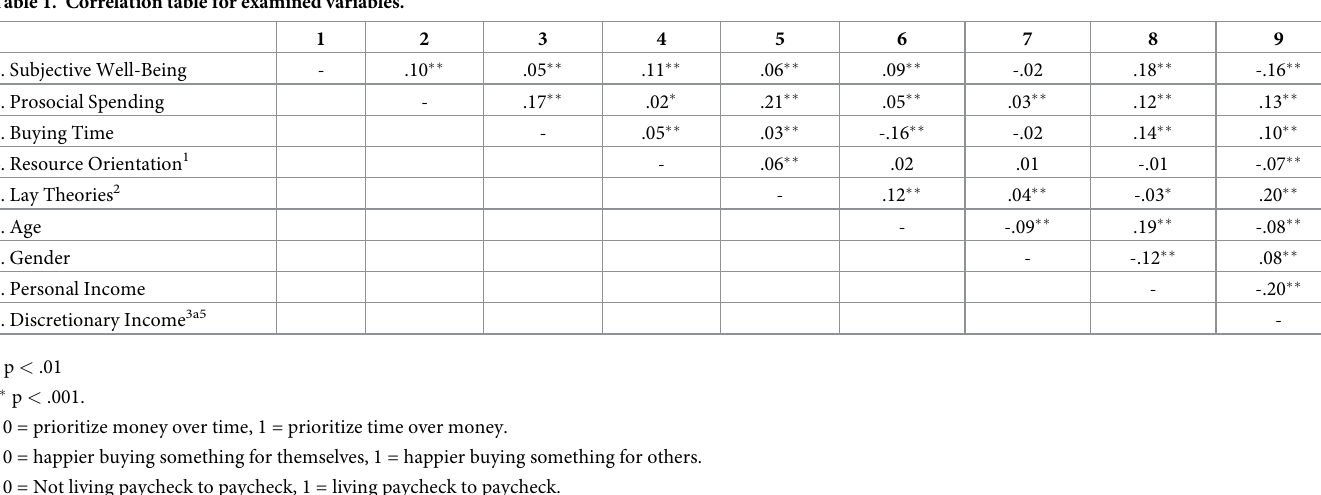
Table 1. Correlation table for examined